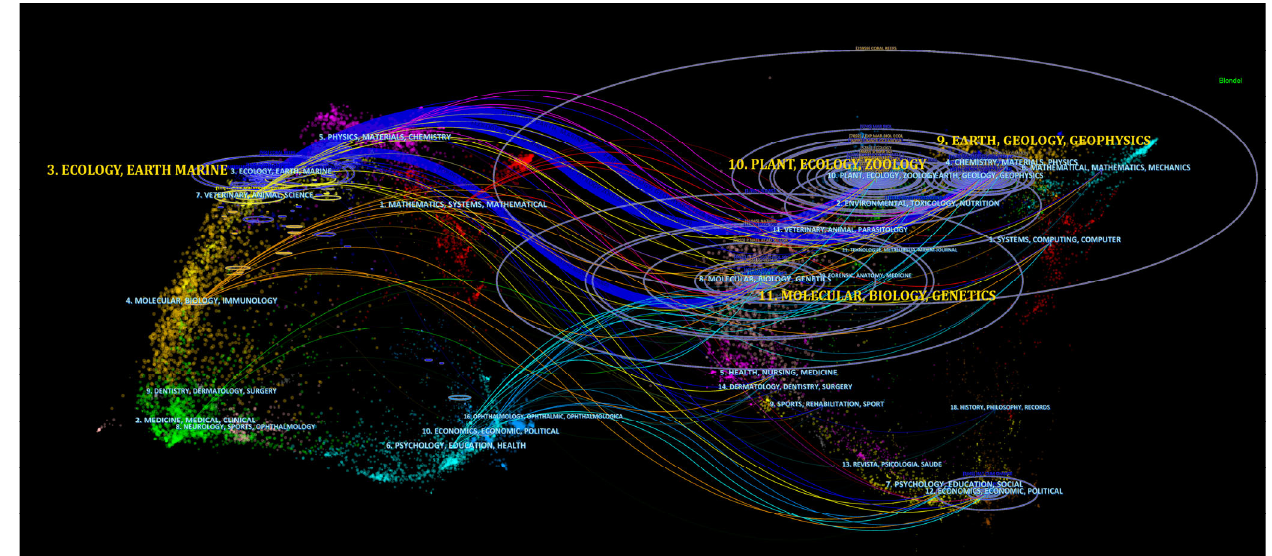
Figure 10. Dual ‐ map overlay on the impact of climate change on coral reefs research . Figure 10. Dual-map overlay on the impact of climate change on coral reefs